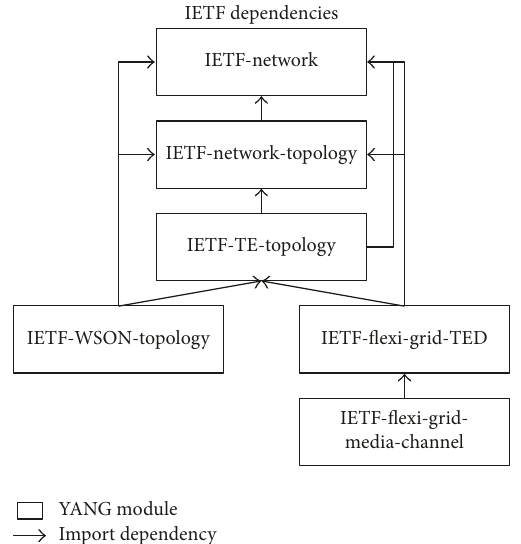
Figure 2: Import hierarchy of IETF YANG